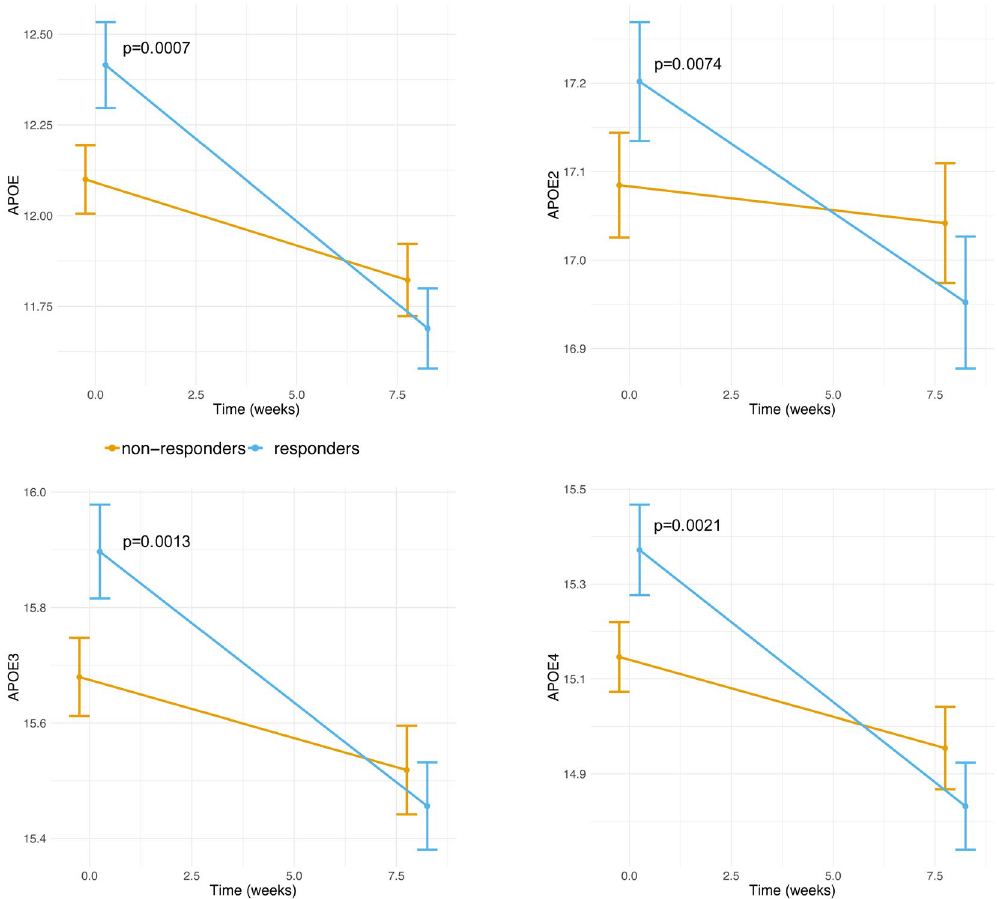
Figure 5. Evolution of somamers pertaining to ApoE during LCD. Data are shown as mean + / − 95% CI per group (responders/non-responders). P-values compare the difference between responders and non-responders at a given CID. Those p-values are adjusted for gender, age and center. P-values greater than 5% are not shown. Values on the Y axis correspond to relative fluorescence units, as provided by the Somalogic platform.